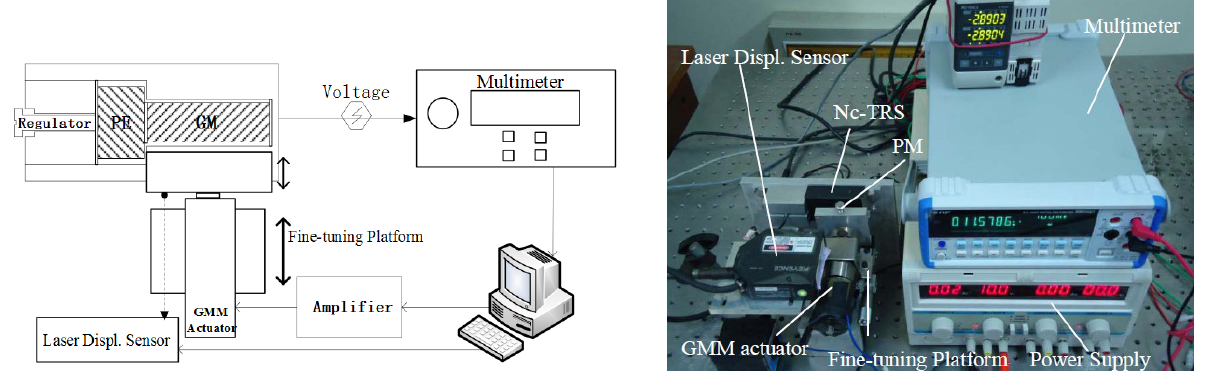
Figure 3. The schematic diagram and the photograph of the experimental setup for displacment